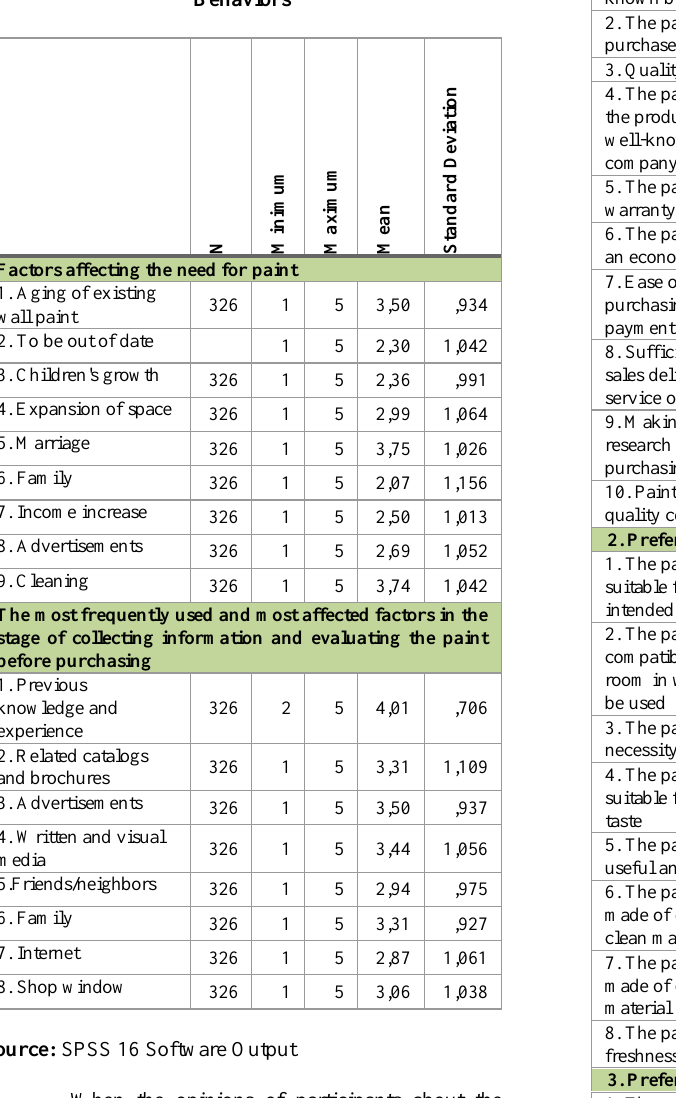
Table 13: Findings Regarding Purchasing and Usage Behaviors